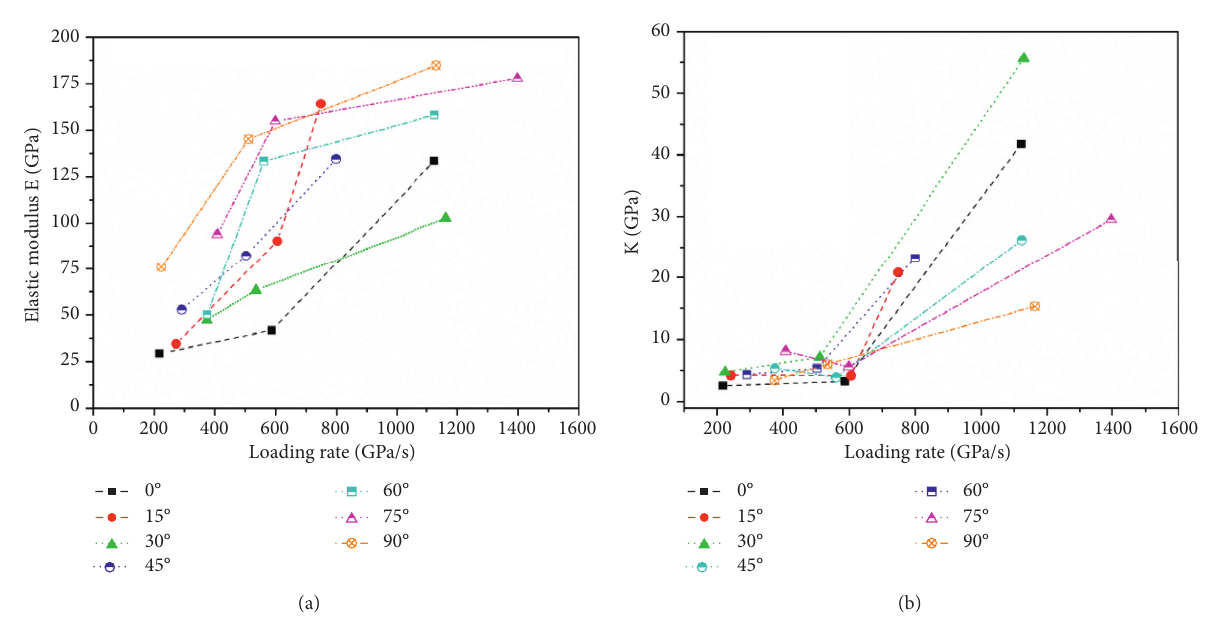
Figure 6: The elastic modulus E and postpeak stress reduction rate K after different loading rates. (a) Law of the change in elastic modulus E with loading rate. (b) Law of the change in K with loading